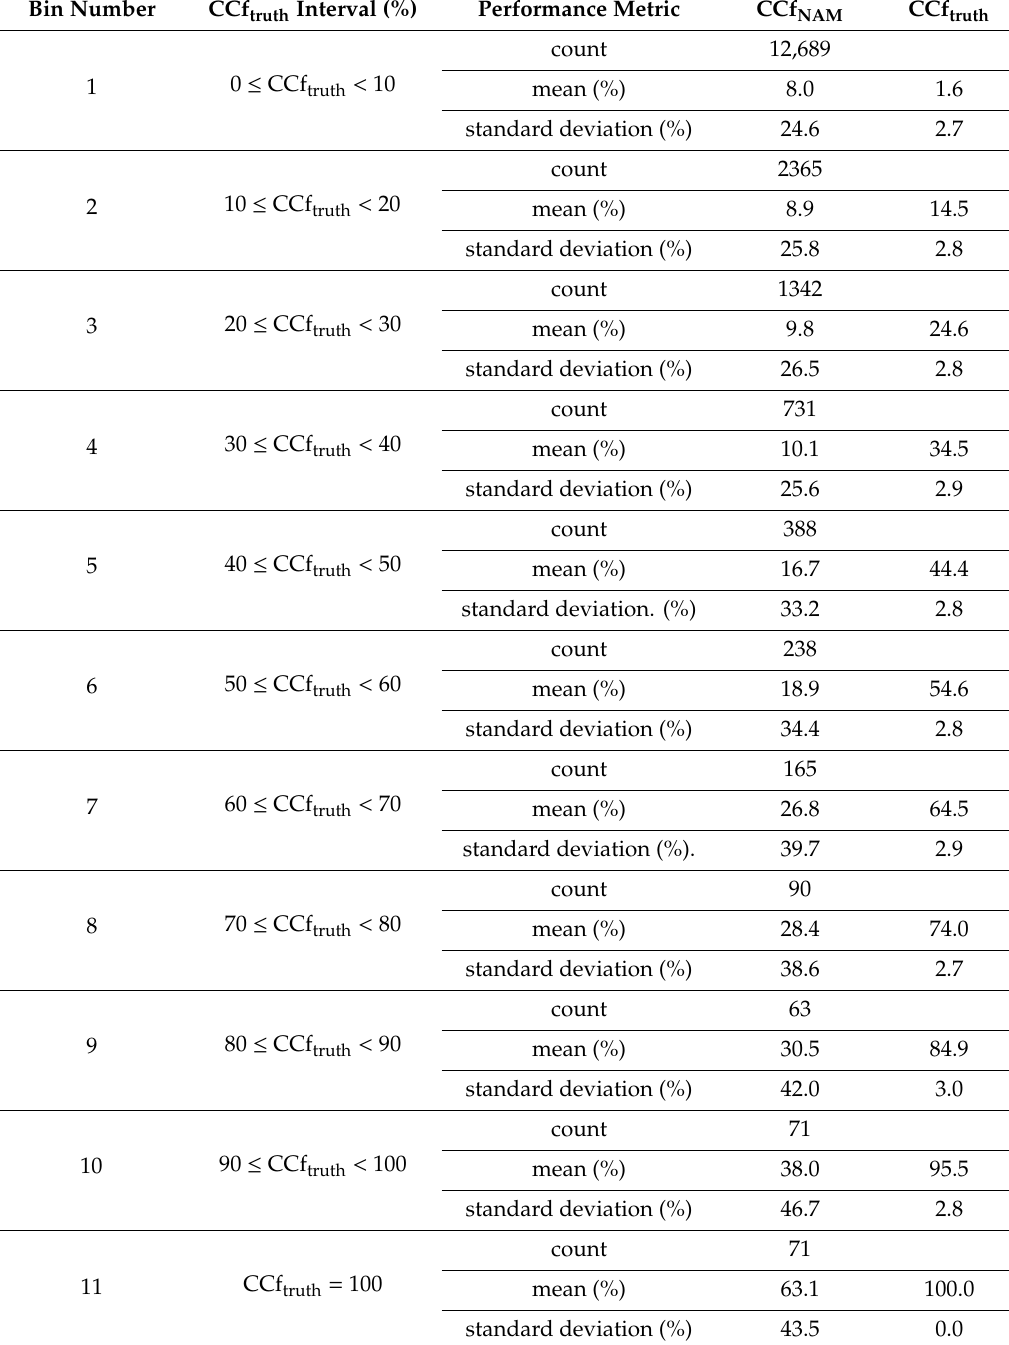
Table 2. Comparisons between cloud cover fraction in NAM data (CCf NAM ) and truth (CCf truth ) for 19 Nov 2014 at 1800 UTC from manual masks of VIIRS imagery between 1757–1803 UTC on 19 Nov